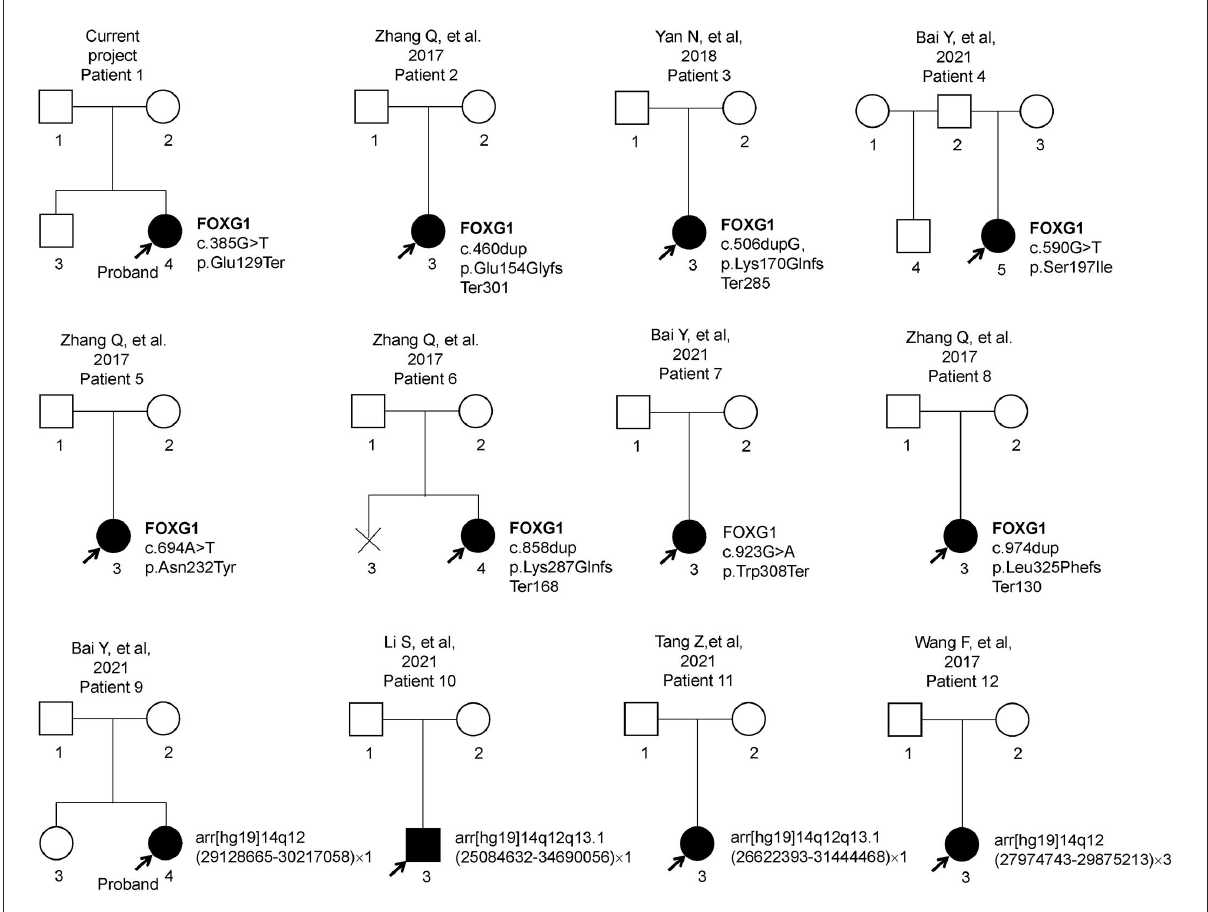
FIGURE2 Pedigrees of 12 patients with FOXG1-related encephalopathy.